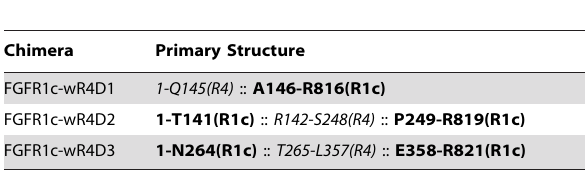
Table 3. FGFR1c/FGFR4 chimeras used to determine Avimer binding